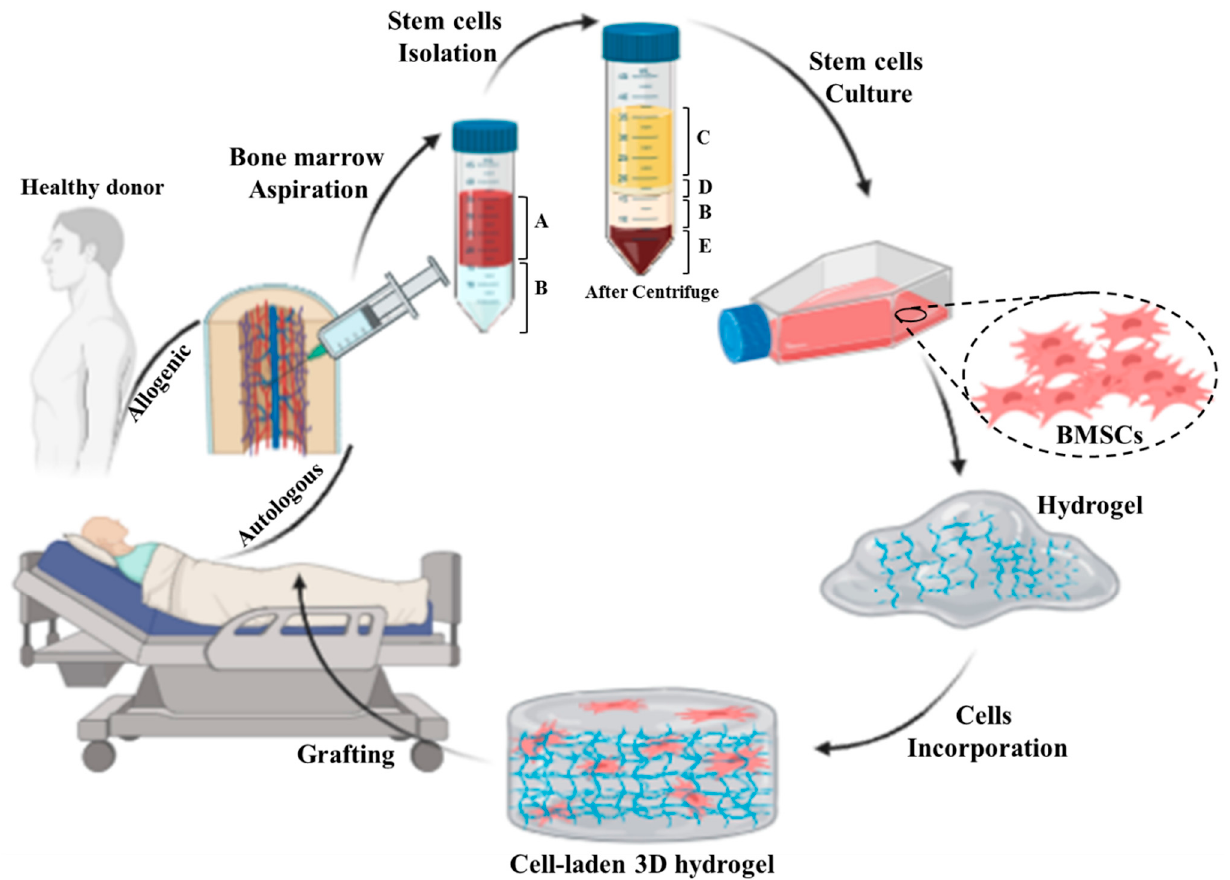
Figure 3. Schematic representing preparation process of an autologous/allogenic stem cell-laden hydrogel for skin regenerative approaches: the bone marrow is aspirated from donor or patient own and then the stem cells are isolated from bone marrow. Afterward, the BMSCs are cultured and incorporated/encapsulated in a hydrogel solution. Finally, the cell-laden hydrogel is pre/post-crosslinked and grafted to the injured site. (A: whole blood, B: Ficoll gradient, C: plasma, D: mononuclear cell, and E: red blood cells).